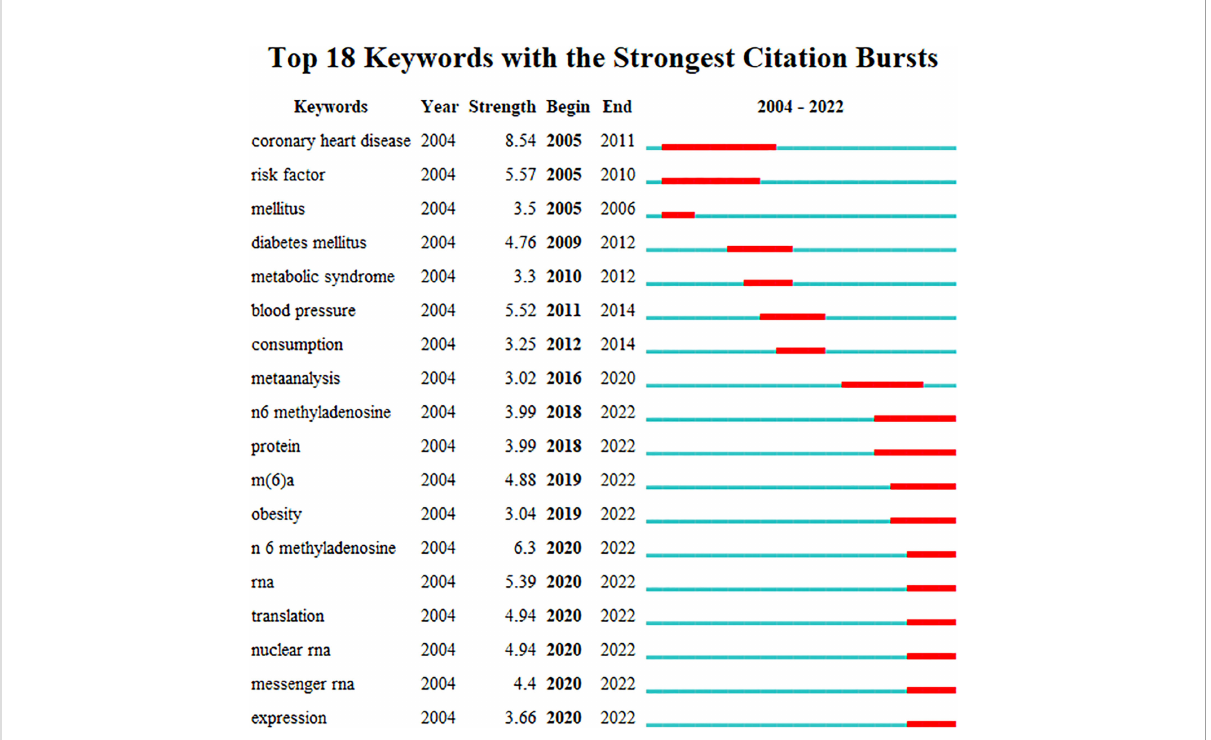
FIGURE 10 Keyword bursts related to RNA methylation in DM and its complications.